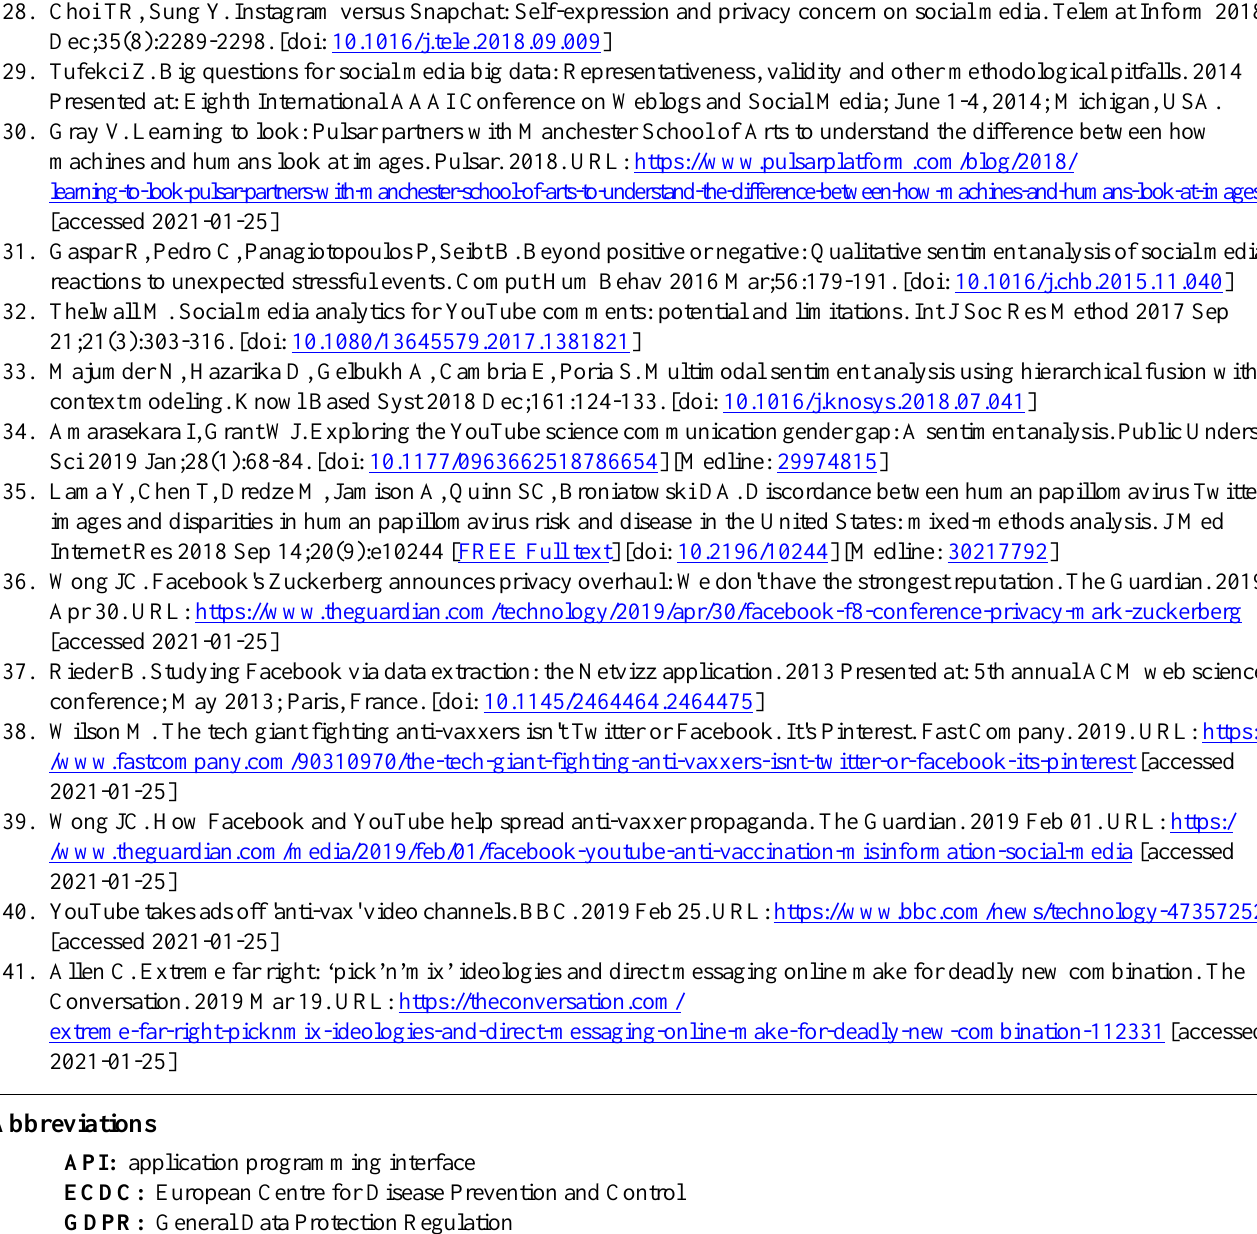
ECDC: European Centre for Disease Prevention and Control GDPR: General Data Protection Regulation HPV: human papillomavirus VCP: Vaccine Confidence